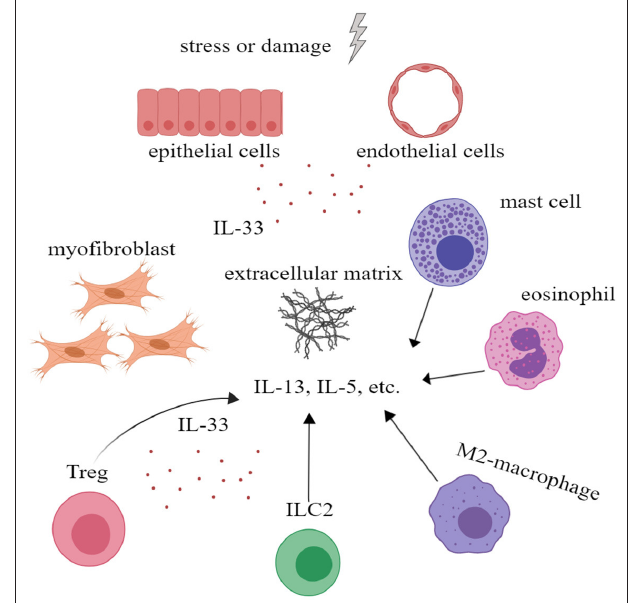
IL-33 could promote the proliferation of Treg to further alleviate inflammation. IL-33 could also promote extracellular matrix deposition and tissue fibrosis by acting on mast cells, eosinophil, M2 macrophage, ILC2 cells, and Treg to increase the secretion of IL-5, IL-13, and other cytokines. ILC, innate lymphoid cell; Treg, regulatory T